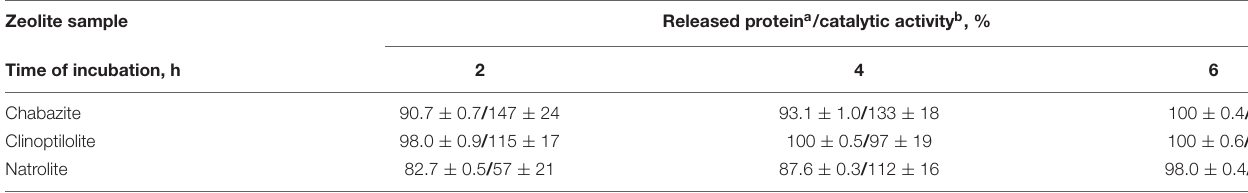
TABLE 2 | The amount of binase protein released from zeolite samples into MQ-water and catalytic activity of the released enzyme. Zeolite